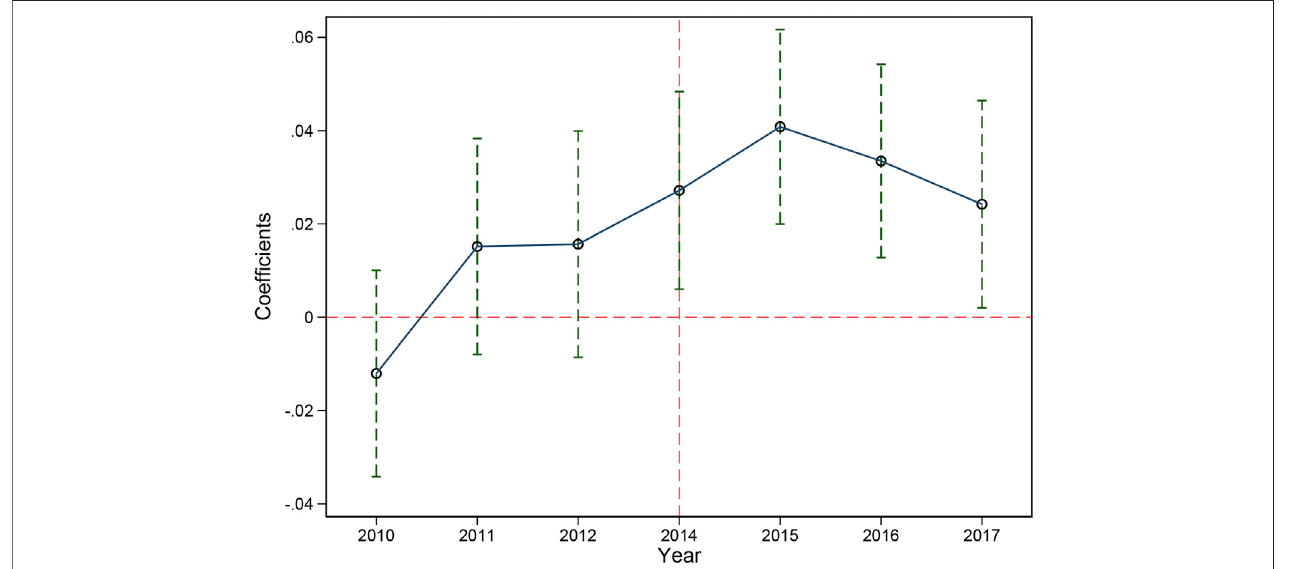
FIGURE 3 | The Results of the parallel trend test.